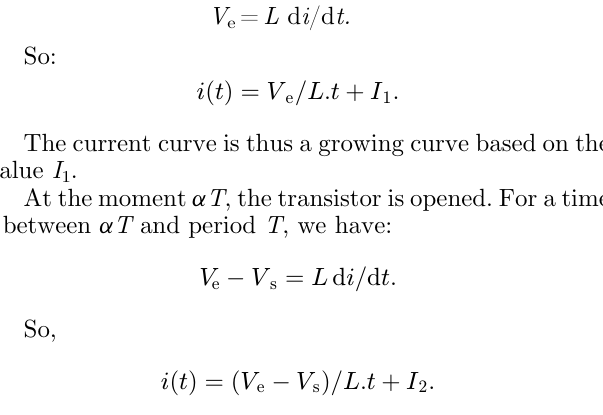
Figure 3 explicates the characteristics of power – voltage ( P – V ) and current – voltage ( I – V ) of a PV panel using Simulink interface of Matlab software. This panel model is composed of 12 solar cells in series as shown in Table 1.